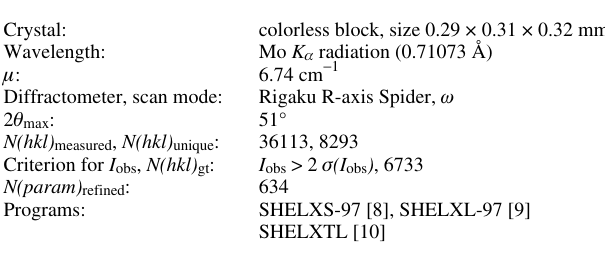
Table 1. Data collection and